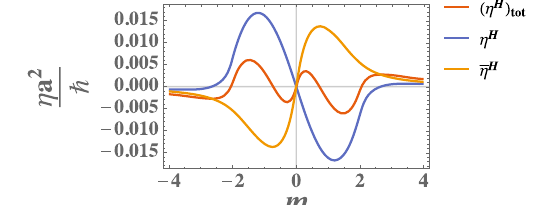
, η H , and ¯ η H as a total